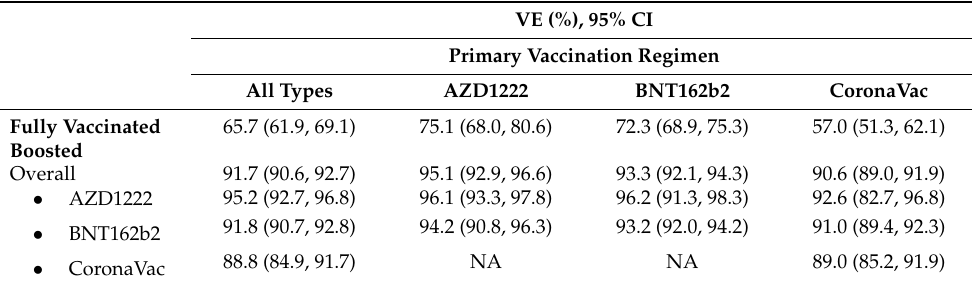
Table 3. Vaccine effectiveness estimates in preventing deaths among COVID-19 cases, according to vaccination status, types of vaccines for primary regimen and